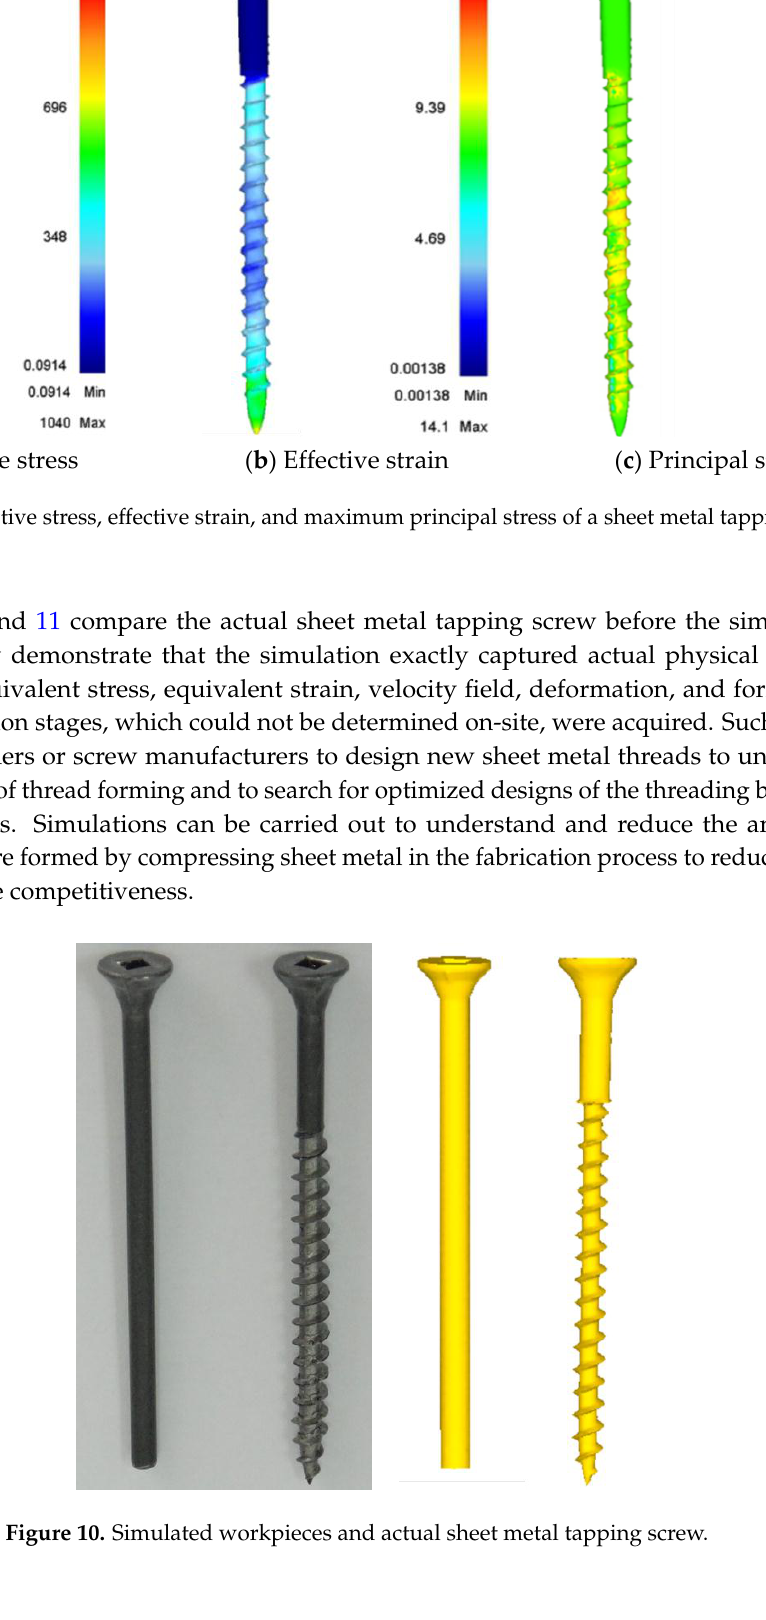
Figure 8. Refined grid around workpiece.